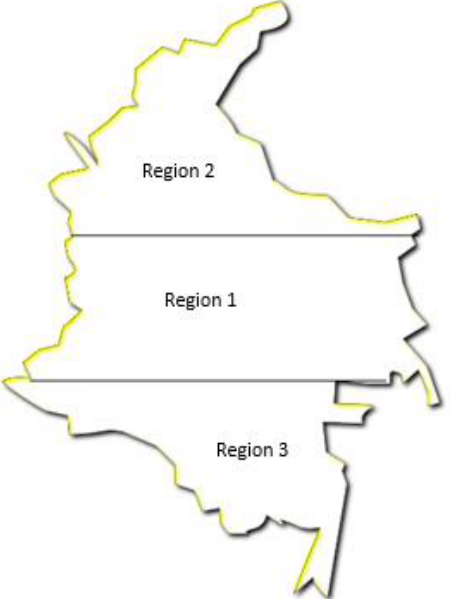
Figure 1. Regions proposed for model and scenario simulation. Source: own elaboration.